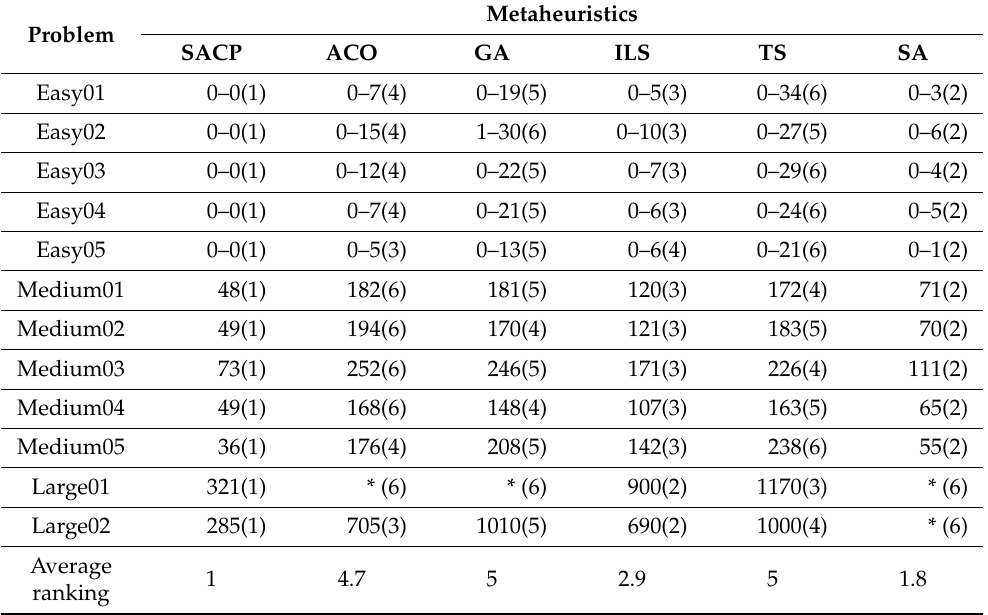
Table 5. Comparison of results obtained by the SACP metaheuristic with other results obtained by other metaheuristics at a time limit of 9000 s for large problems, 900 s for medium problems and 90 s for small